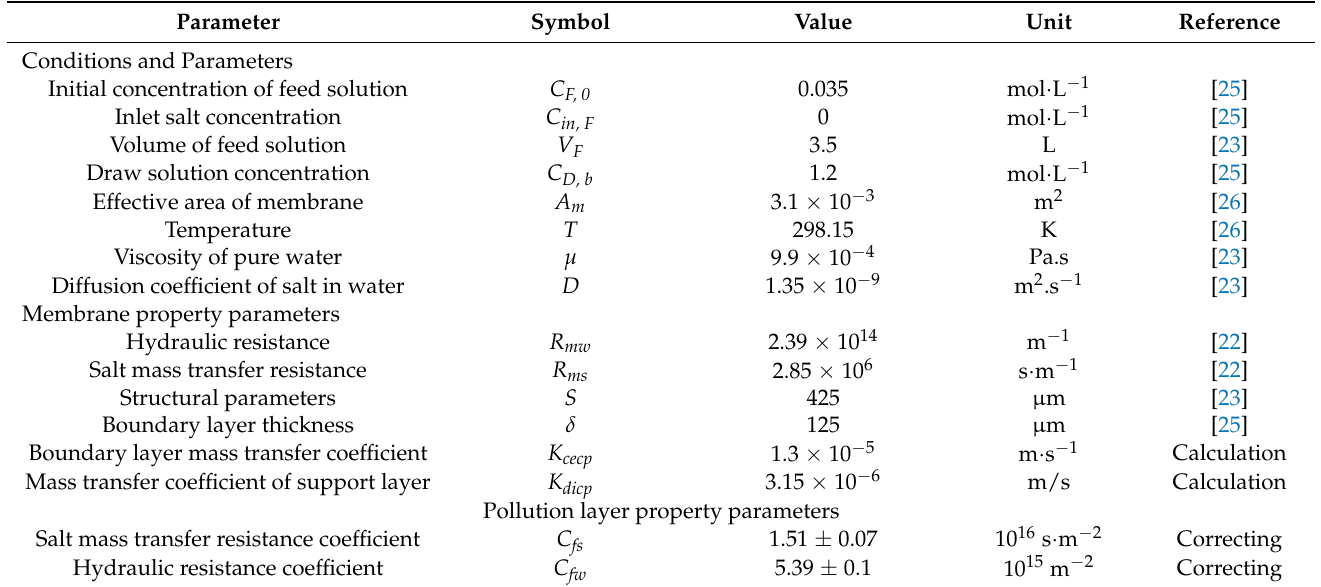
Table 1. Experimental conditions and model